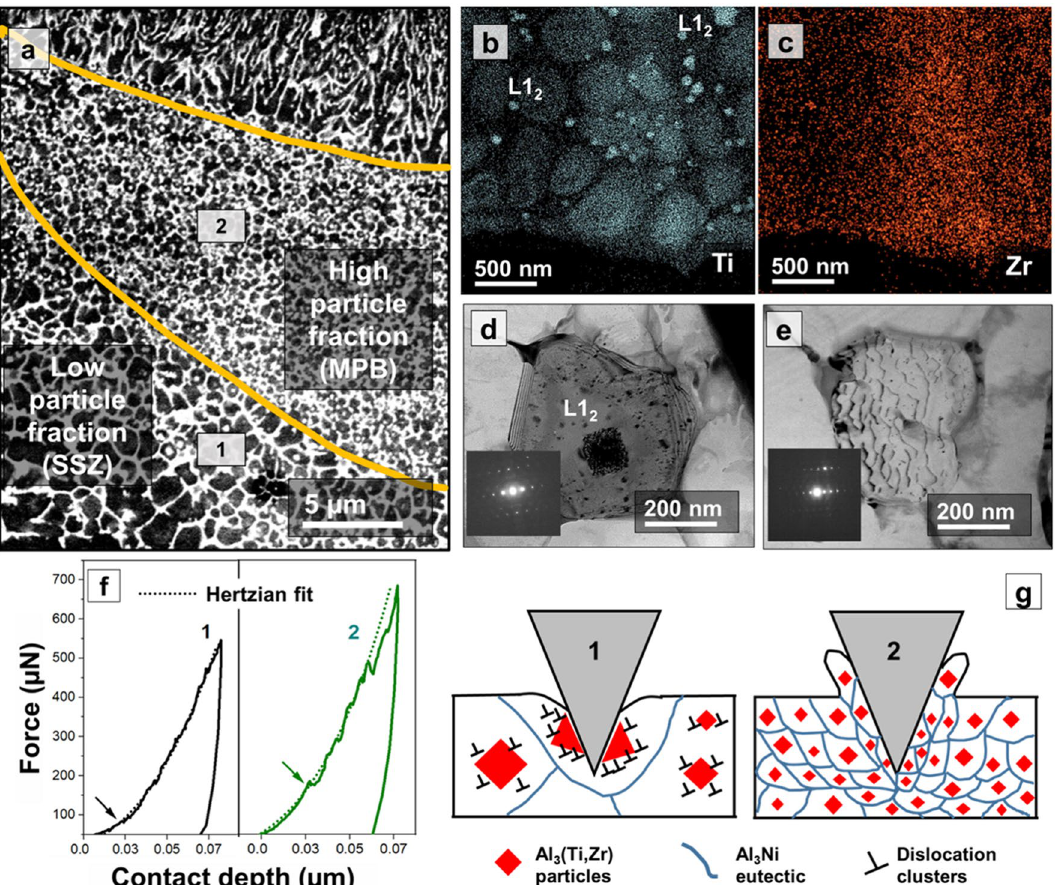
Figure 4. Nanomechanical effect of particle size, coherency, and volume fraction ( a ) The immersion mode high-magnification BSE images captured near melt pool boundary, ( b , c ) STEM-EDS maps show variations in particle composition and volume fraction within the pool boundary, ( d , e ) high magnification TEM reveals variation in dislocation pattern in particle rich and depleted grains ( f , g ) nanoindentation P–h curves captures the nanomechanical impact of such heterogeneity in particle distribution, and ( g ) schematics illustrate two possible particle-indenter interactions depending on the local particle